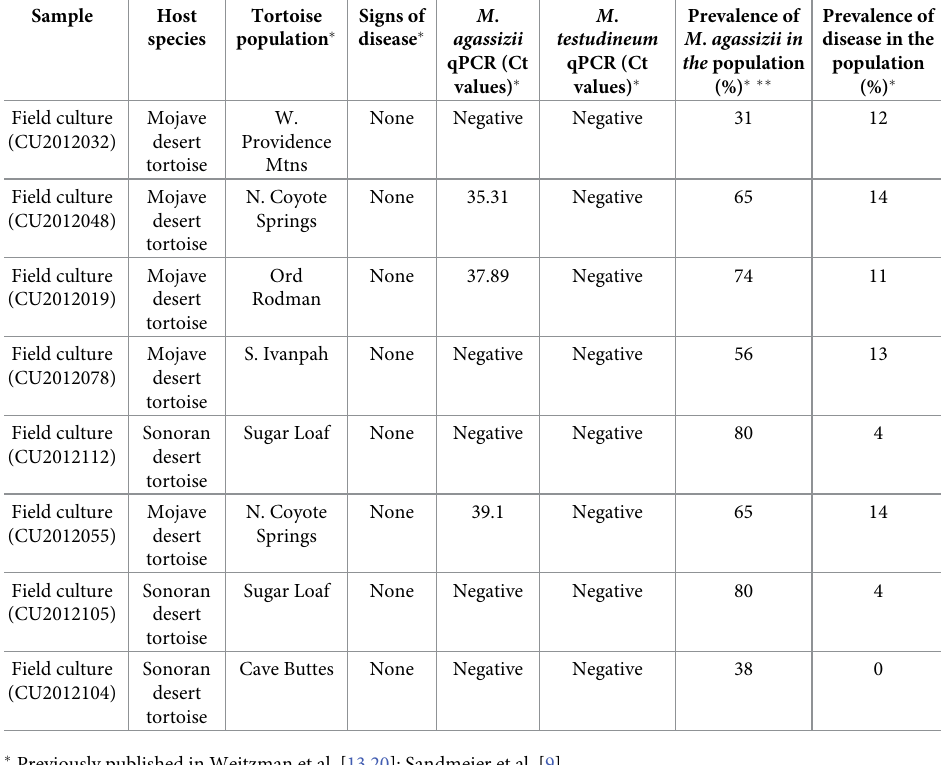
Table 3. Disease status (clinical signs and Mycoplasma agassizii ) of individuals and their respective populations from which high-quality genome sequences were obtained (see Table 1). Sample Host Tortoise Signs of disease species population �